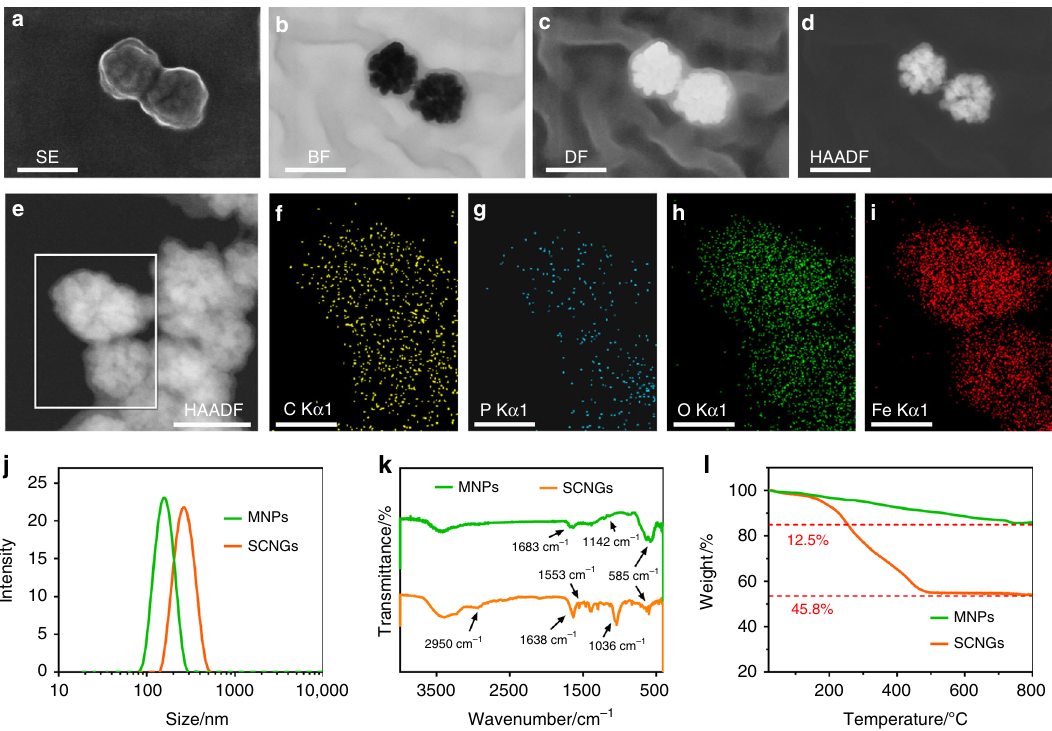
Fig. 2 Construction and characterization of SCNGs. The STEM images of SCNGs using different modes and energy dispersive X-ray (EDX) spectroscopy mapping images of the C, P, O and Fe elements ( a SE: second electronic, b BF: bright fi eld, c DF: dark fi eld, d , e HAADF: high-angle annular dark fi eld). j The size distribution of MNPs (green line) and SCNGs (orange line) in buffer. k FT-IR spectra of the MNPs (green line) and SCNGs (orange line). l TG test of the MNPs (green line) and SCNGs (orange line). Scale bar in a – e , 100 nm. Scale bar in f – i , 50 nm. Source data are provided as a Source Data fi